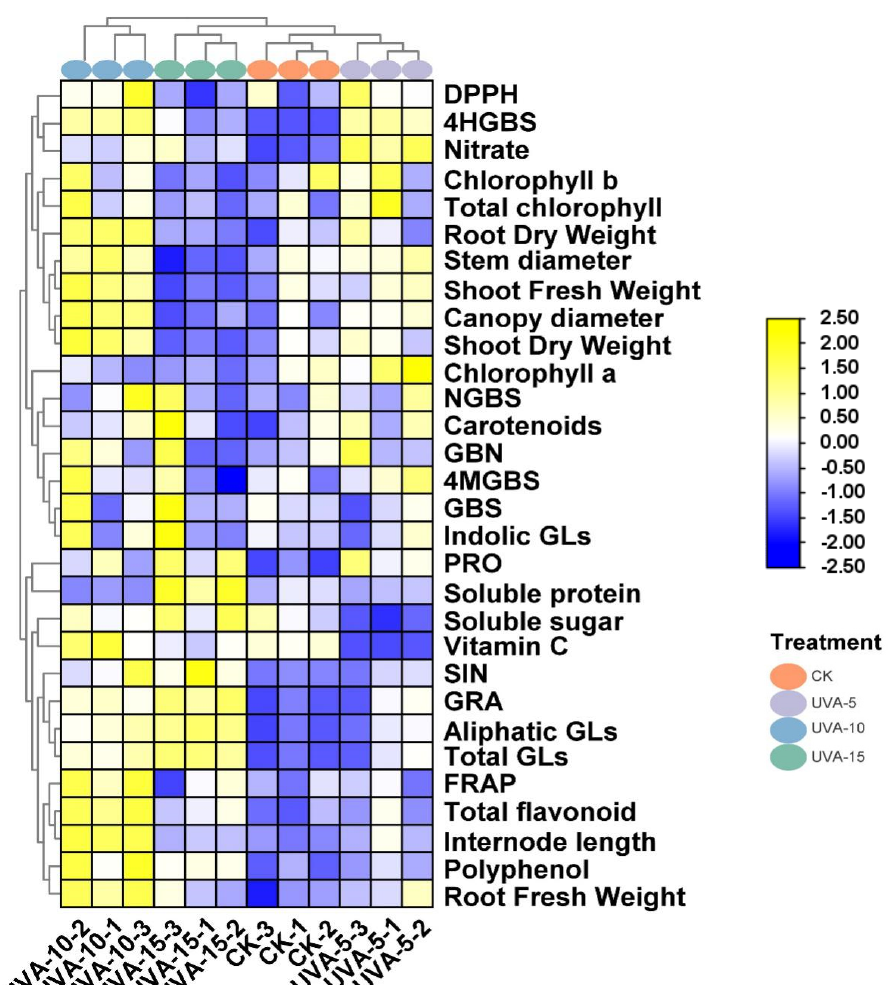
Figure 7. Heatmap analysis summarized the effect of different supplemental UV-A intensity on growth and quality of Chinese kale baby-leaves. Results were visualized using a false color scale, with yellow and purple indicating an increase and decrease, respectively, in the response parameters.